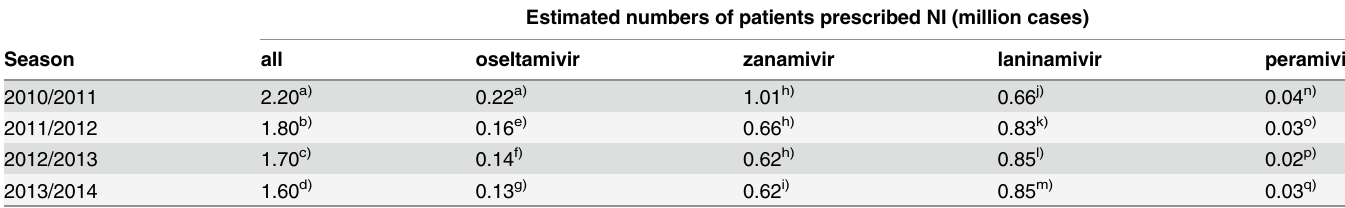
Table 1. Estimated number of 10 – 19-year-old patients prescribed neuraminidase inhibitors each season (million